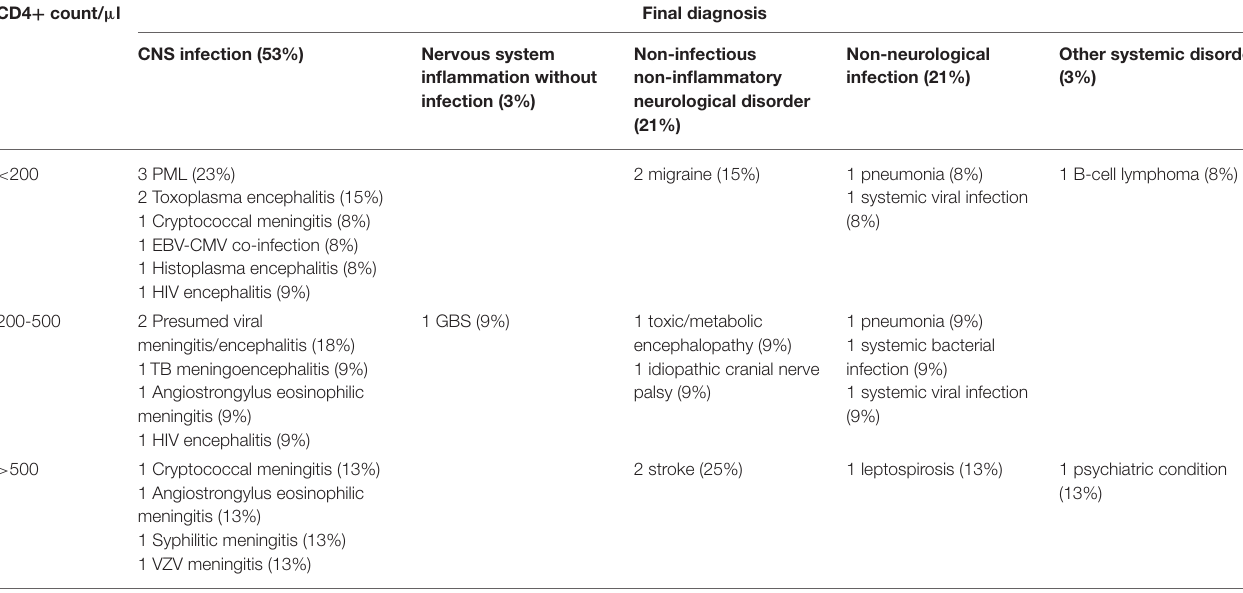
TABLE 2 | Final diagnosis based on CD4 counts in HIV-infected patients and associated pathogens in episodes of central nervous system